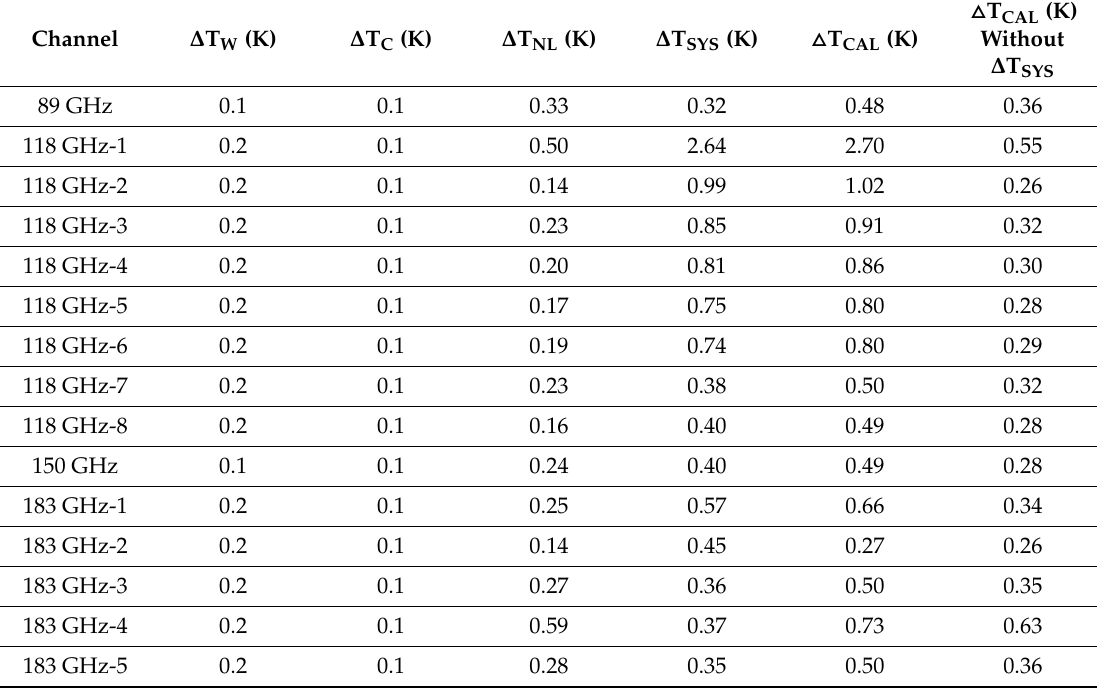
Table 2. Primary calibration results of MWHTS: ∆ T W and ∆ T C are uncertainty of warm and cold target, respectively; ∆ T NL is uncertainty caused by nonlinearity; ∆ T SYS is uncertainty from system noise; and (cid:52) T CAL is calibration uncertainty with system noise